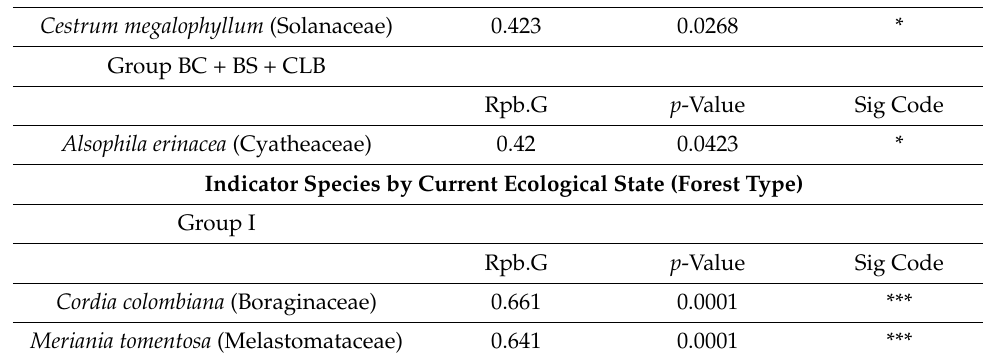
Table 4. Cont. Indicator Species by